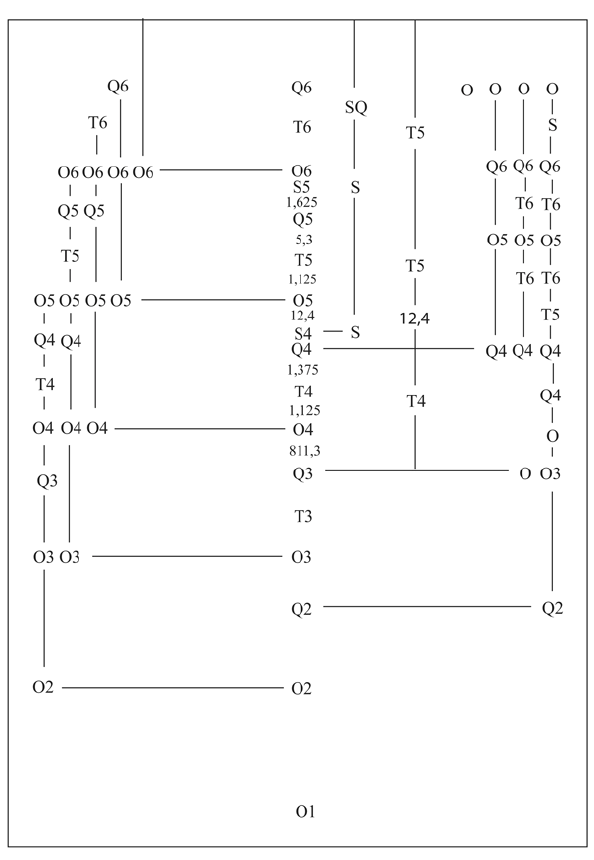
FIGURE 3 . The tree of overtones. The image is shown as its pattern would look on a millimeter